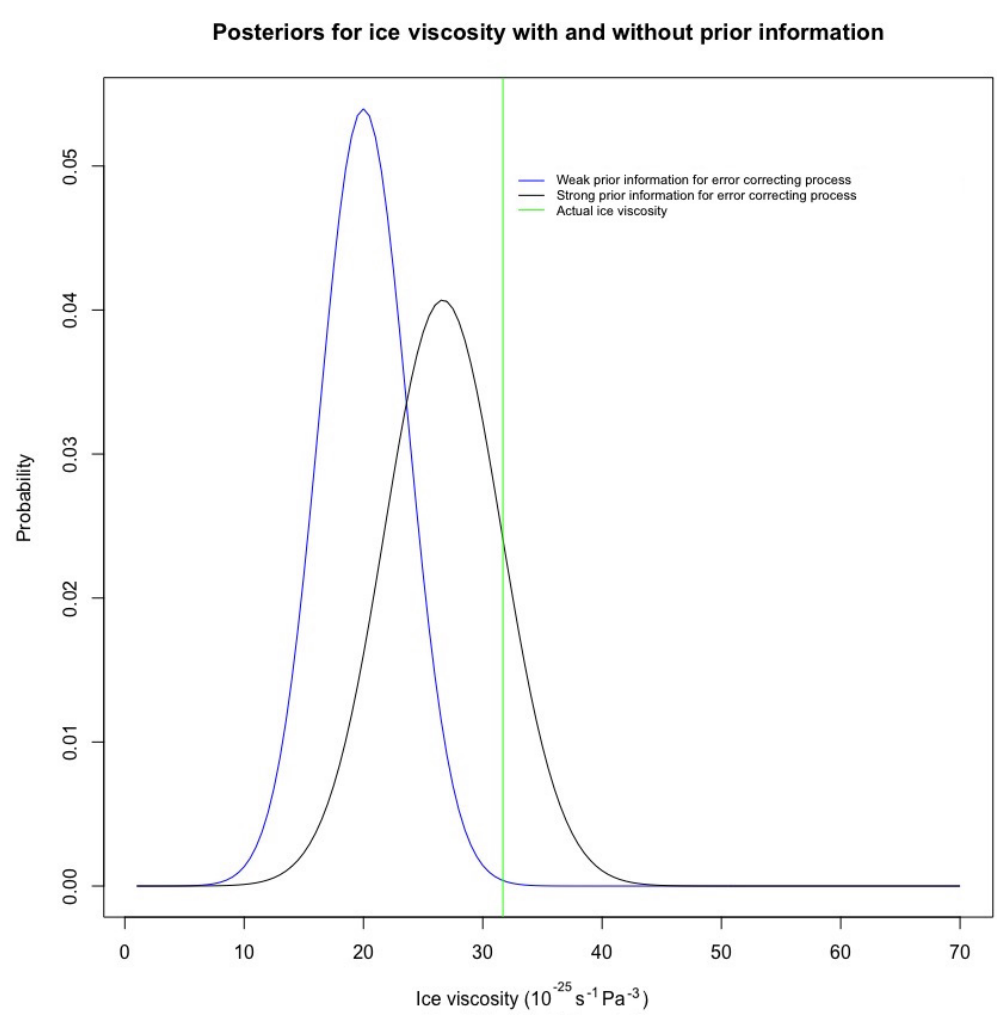
Figure 8. A comparison of posteriors under strong and weak prior information for the error-correcting process in test case D (i.e., mass balance field producing a periodic SIA solution); prior information for the error-correcting process leads to a less biased posterior, though with slightly more posterior